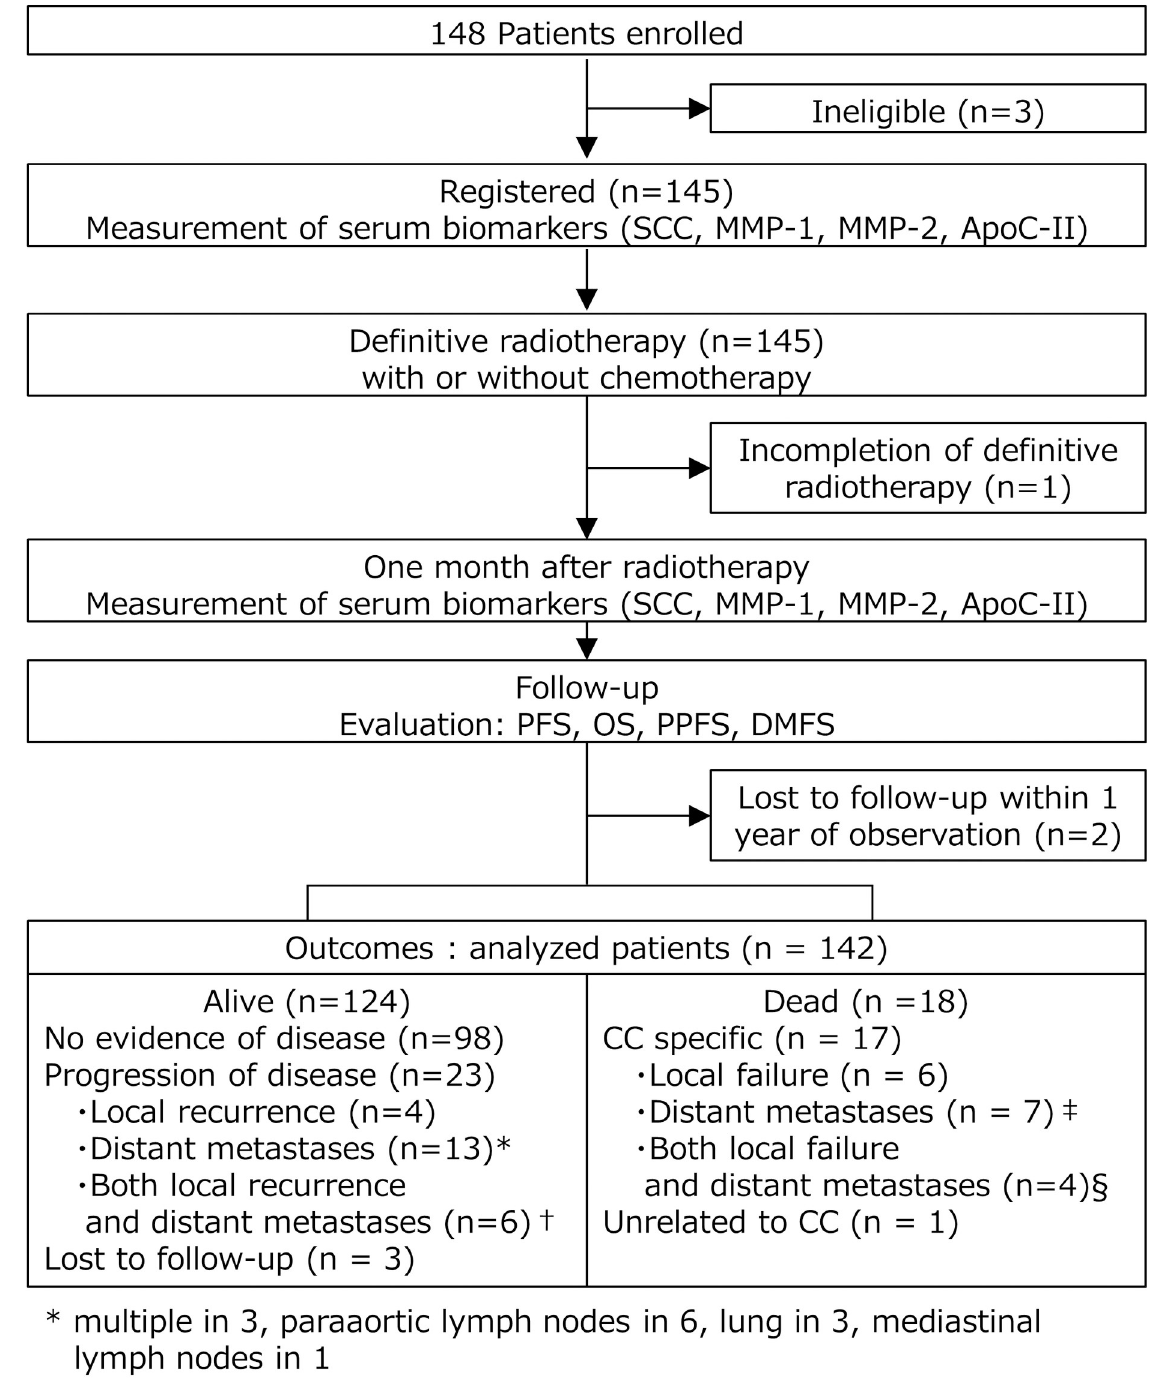
PLOS ONE | https://doi.org/10.1371/journal.pone.0259235 November2,